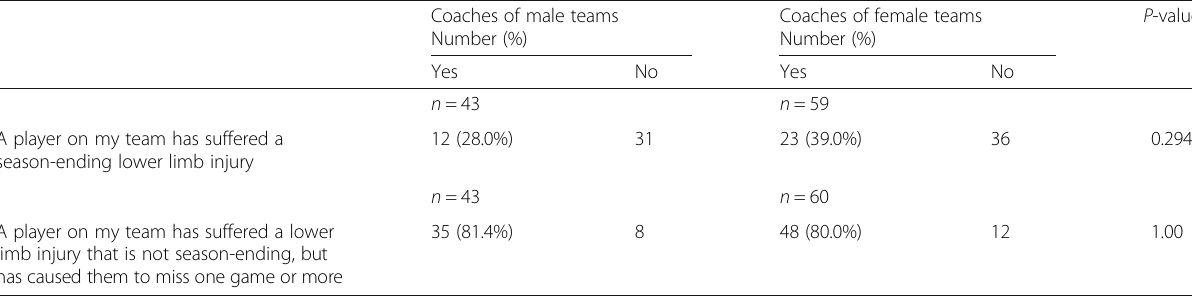
Table 2 Injury incidence of male and female teams